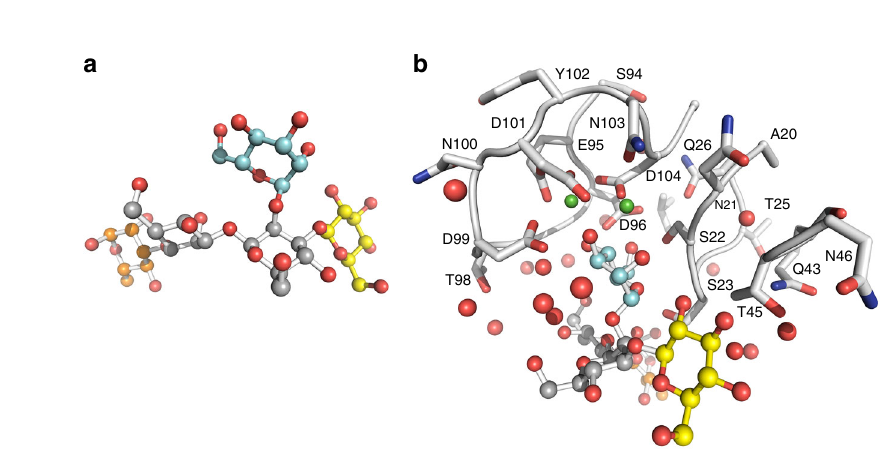
Fig. 3 Modeling of LecB – Psl interactions favors binding to the side chain of Psl. a Overall conformation of the docked Psl pentasaccharide is represented as α -D-mannopyranose in cyan, β -D-mannopyranose in gray, α -L-rhamnopyranose in orange, and β -D-glucopyranose in yellow. Oxygen atoms are labeled in red. b Structural model of Psl docking in LecB binding site is favored to occur in the α -1,2 ′ mannobiose. LecB is depicted in white, water molecules are the red spheres, the green ones are Ca + 2 ions, and Psl follows the same color code from ( a